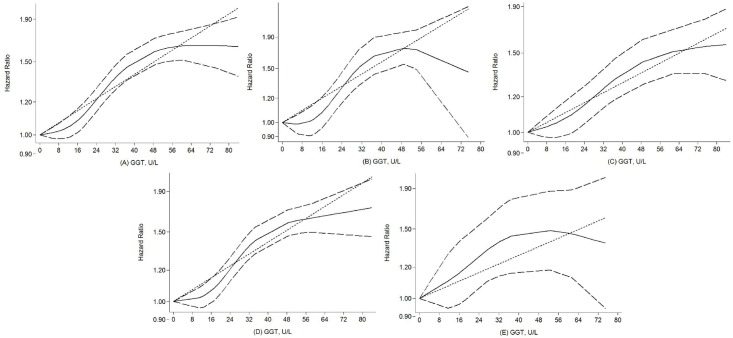
Dose-response relationship between serum GGT levels and risk of CV-mortality in prospective studies.Restricted cubic splines and generalized least squares dose-response models on evaluation of association between GGT and risk of CV mortality. (A) Overall analysis; (B) females; (C) males; (D) Europe; (E) Asia. The solid line represents the fitted hazard Ratio curve compared to the subgroup with the lowest mean levels of serum GGT, and Lines with long dashes represent 95% CI of this risk by restricted cubic splines model. Lines with short dashes represent the weighted regression index compared to subgroup with lowest mean levels of serum GGT by generalized least squares model.